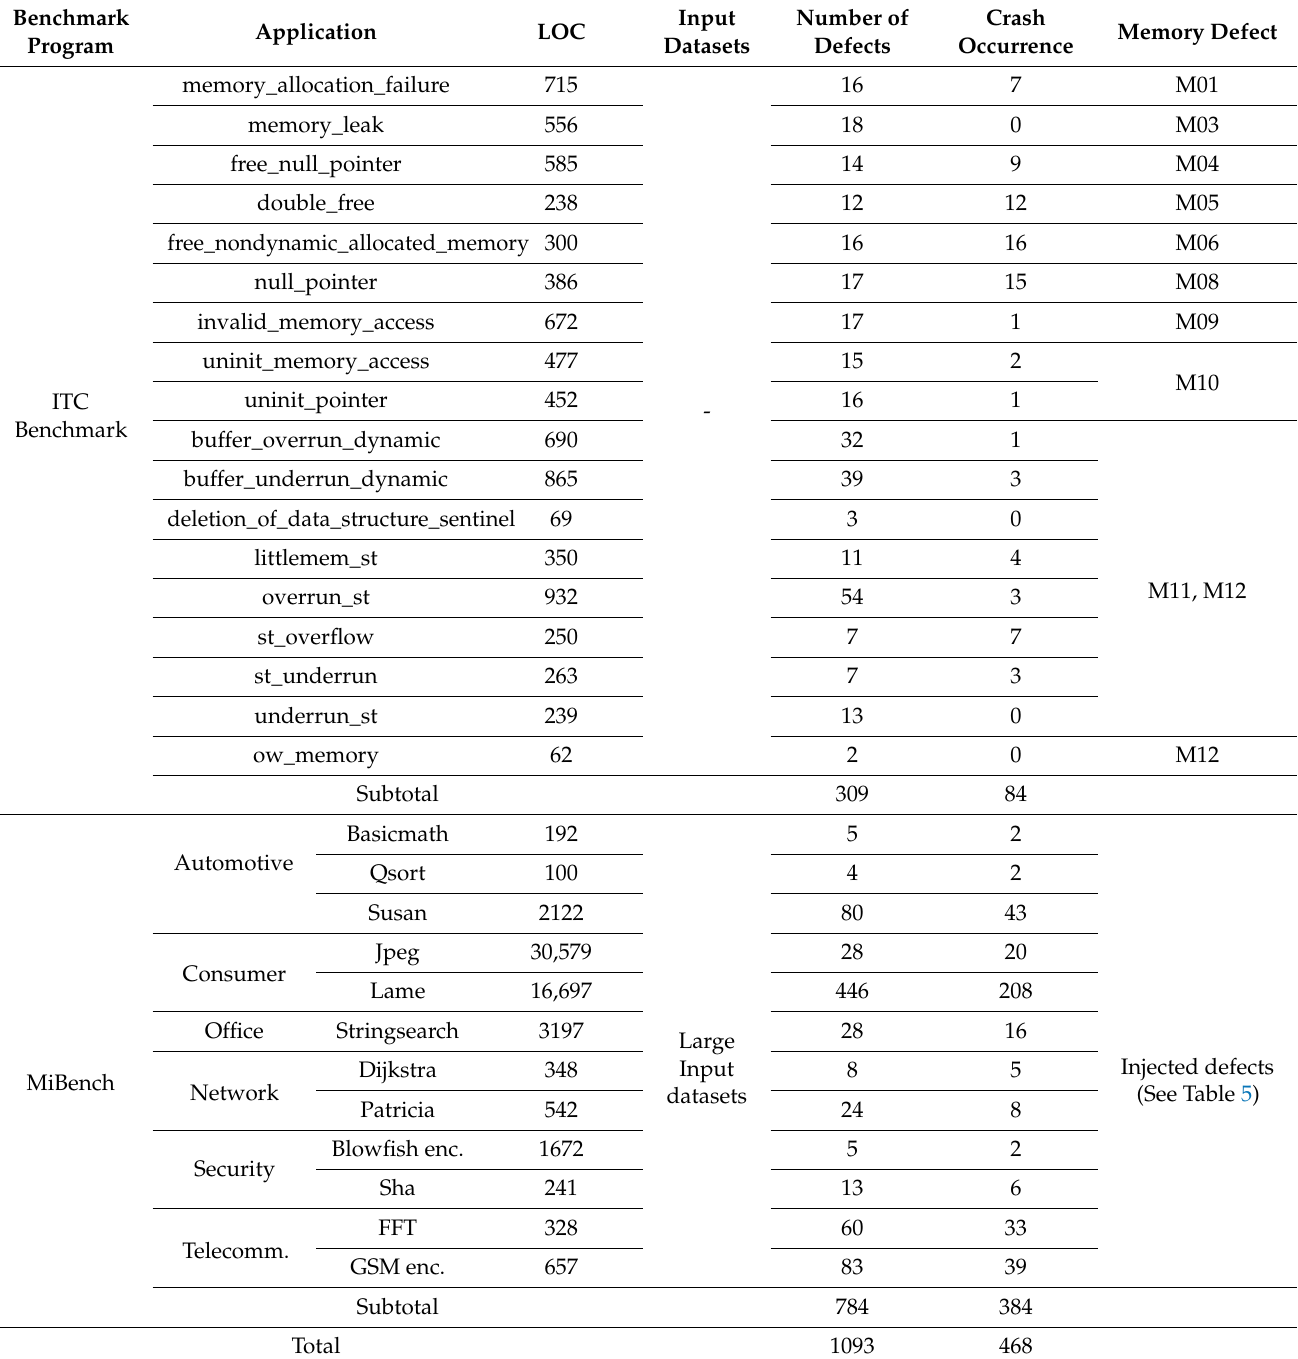
Table 4. Benchmark